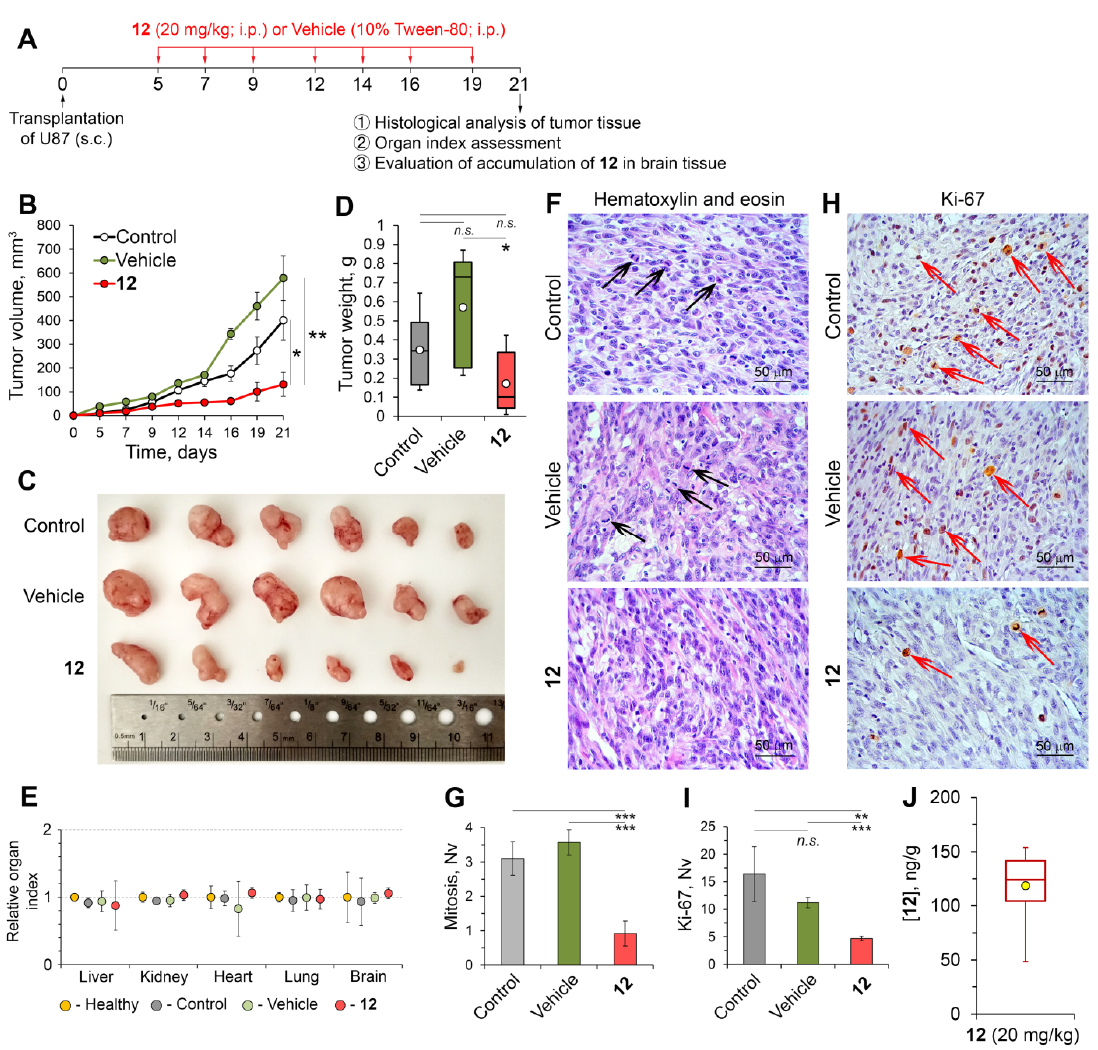
Figure 8. The study of the antitumor activity of 12 in a subcutaneous U87 glioblastoma xenograft model. ( A ) Experimental setup. The xenograft model was induced by subcutaneous (s.c.) injection of U87 glioblastoma cells (2 × 10 7 cells/mL) into the left flank of Balb/C nude mice. On day 5 after tumor transplantation, mice were treated by intraperitoneal (i.p.) injections of 12 in 10% Tween-80 (20 mg/kg) or 10% Tween-80 (vehicle) thrice a week, receiving seven injections in total. Mice were sacrificed on day 21 after tumor transplantation and tumors and brains were collected for histological and HPLC–MS/MS analysis. ( B – D ) Compound 12 effectively suppresses U87 glioblastoma growth. Tumor volumes ( B ), primary tumor nodes ( C ) and tumor weights ( D ) of U87 glioblastomas without treatment and after 12 or vehicle administration. ( E ) Compound 12 does not cause toxic effects in mice. Liver, kidney, heart, lung and brain indexes of tumor-bearing mice without treatment and after 12 or vehicle administration were calculated relative to the organ indexes of healthy mice. ( F , G ) Representative histological images ( F ) and numerical densities of mitoses ( G ) in U87 glioblastoma tissue without treatment and after 12 or vehicle administration. Hematoxylin and eosin staining. Original magnification × 400. Black arrows indicate tumor cells in the state of mitosis. ( H , I ) Representative images of immunohistochemical staining of U87 glioblastoma tissue with primary antibodies against proliferation marker Ki-67 ( H ) and numerical densities of Ki-67- positive cells ( I ) in the tumor tissue without treatment and after 12 or vehicle administration. Original magnification × 400. Red arrows indicate Ki-67-positive tumor cells. ( J ) The concentration of 12 in the brain tissue of tumor-bearing mice injected by 12 at a dosage of 20 mg/kg. The content of 12 in mouse brain tissue was evaluated by the HPLC–MS/MS method. * p < 0.05; ** p < 0.01; *** p < 0.001; n.s. : not statistically